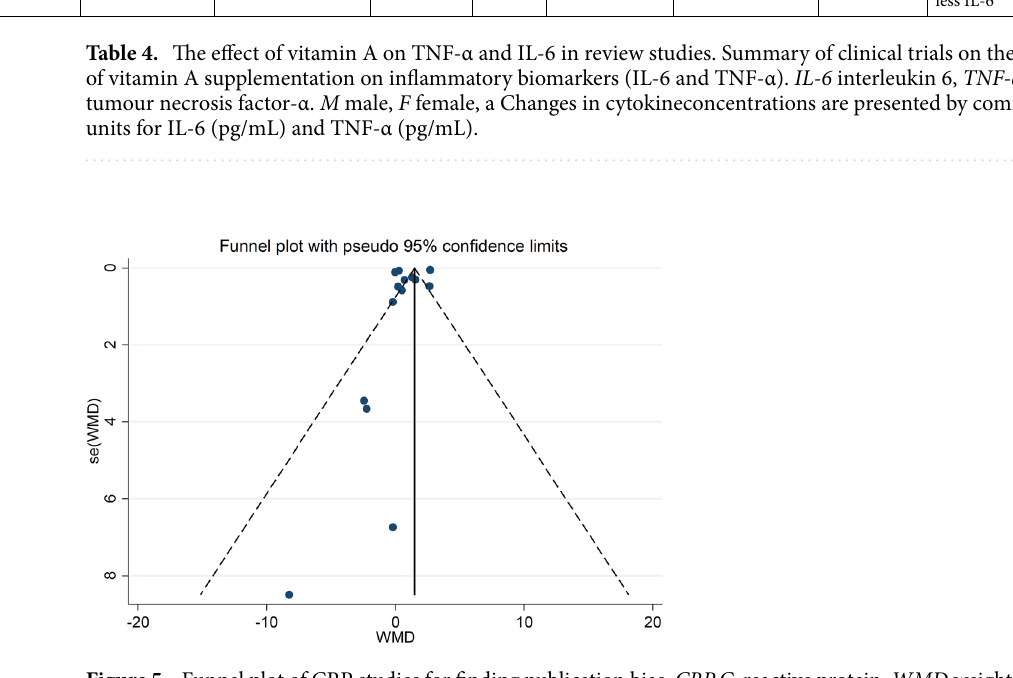
Figure 5. Funnel plot of CRP studies for finding publication bias. CRP C-reactive protein, WMD weighted mean